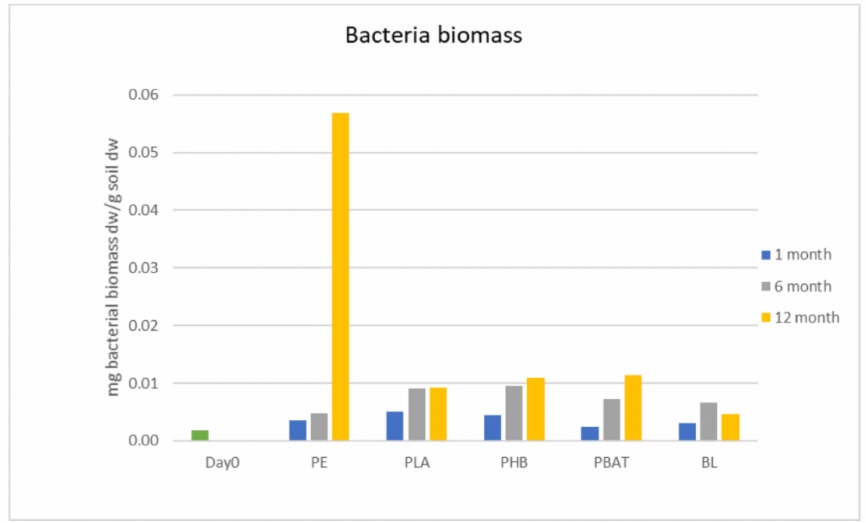
Figure 4. Biomass of bacteria in